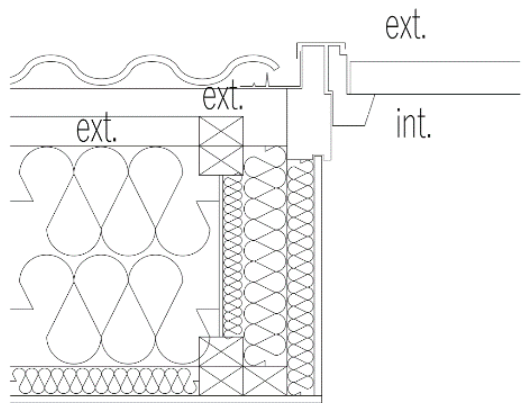
Figure 2. Schematic horizontal cross-section of a typical position of a roof window in a pitched roof.